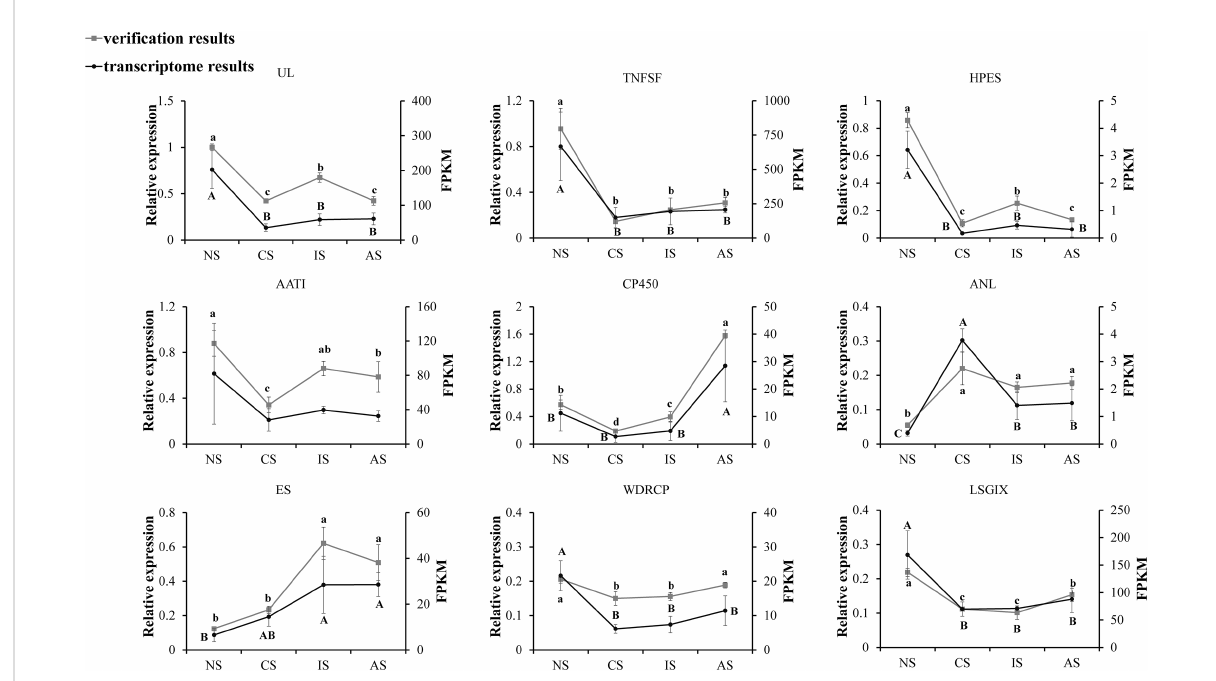
FIGURE 6 Candidate gene expression levels revealed by qRT-PCR and RNA-seq. NS represents normal salinity of 12-13ppt, CS represents coastal low salinity of 3-5ppt, IS represents inland low salinity saline-alkaline water of 1.5-2ppt, AS represents acute low salinity, 3ppt from normal salinity (12-13ppt) directly, which dropped. The different letters above the line chart indicate signi fi cant